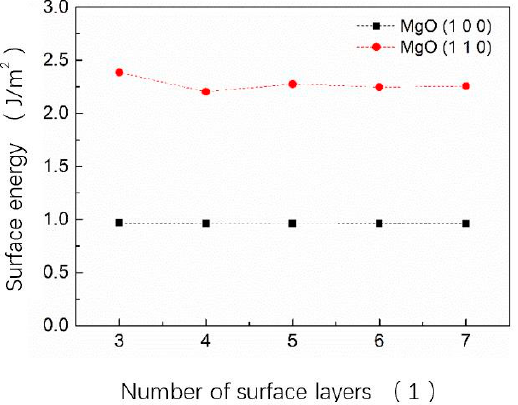
Figure 1. Surface energy of MgO (100) and MgO (110) surface models with different layers.